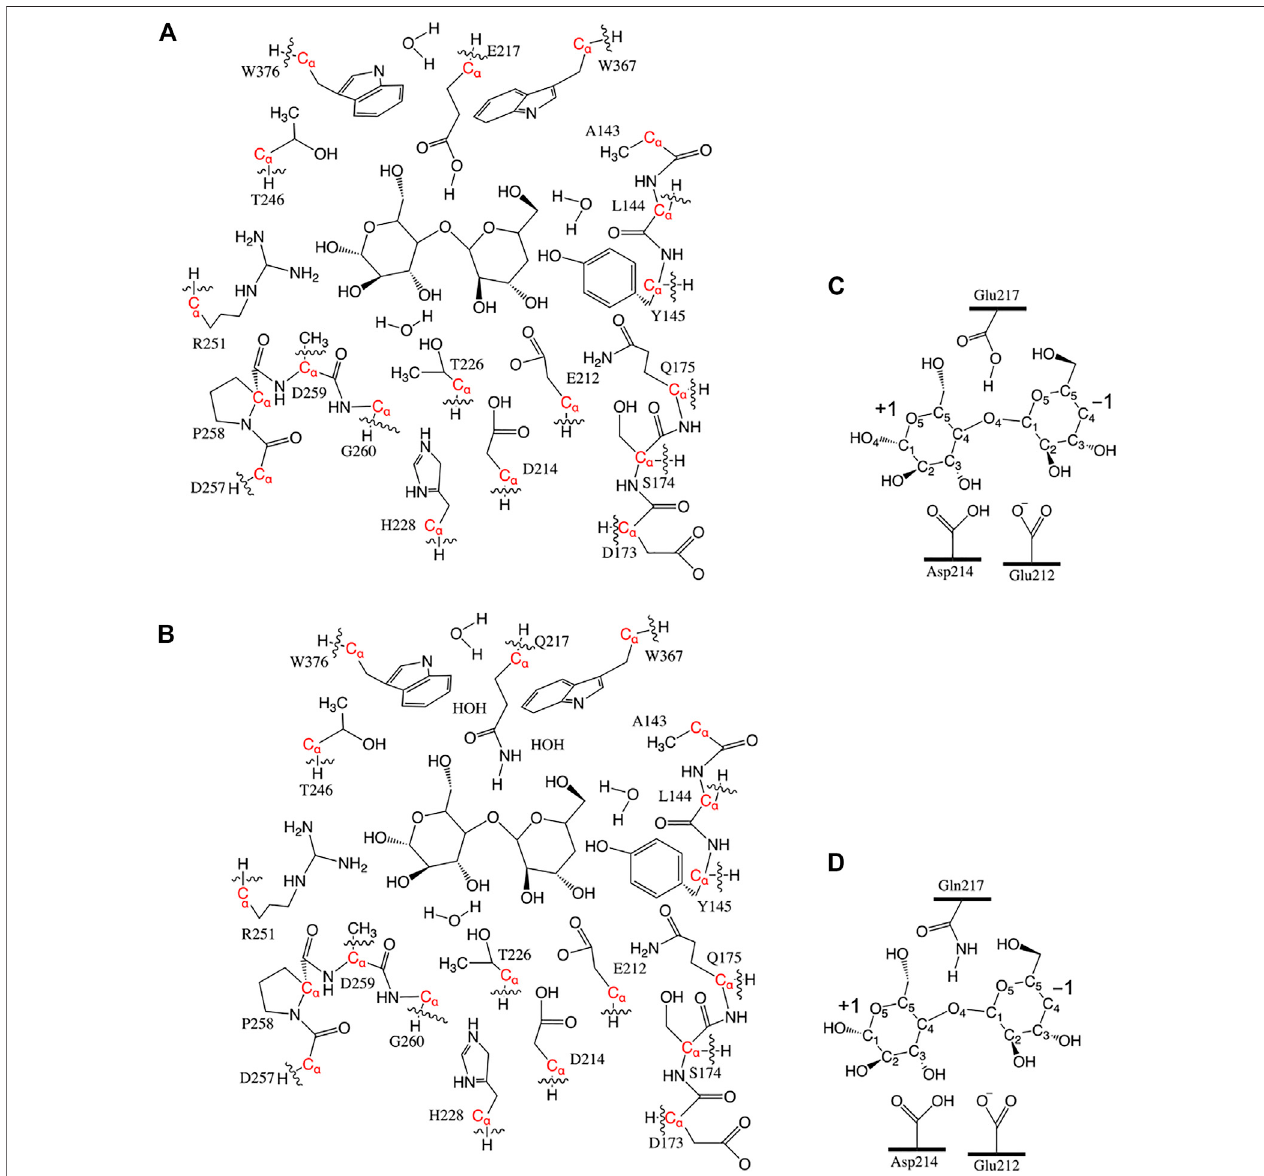
FIGURE2|(A) 2Dstructure ofthe Res21-E (8CEL)model. Thewavylines indicate truncationoftheresidueat C α . (B) 2Dstructure ofthe Res23-Q (4C4C)model. The wavy lines indicate truncation of the residue at C α . Atom labeling scheme of +1 and − 1 glucosyl units (C) in 8CEL and (D) in